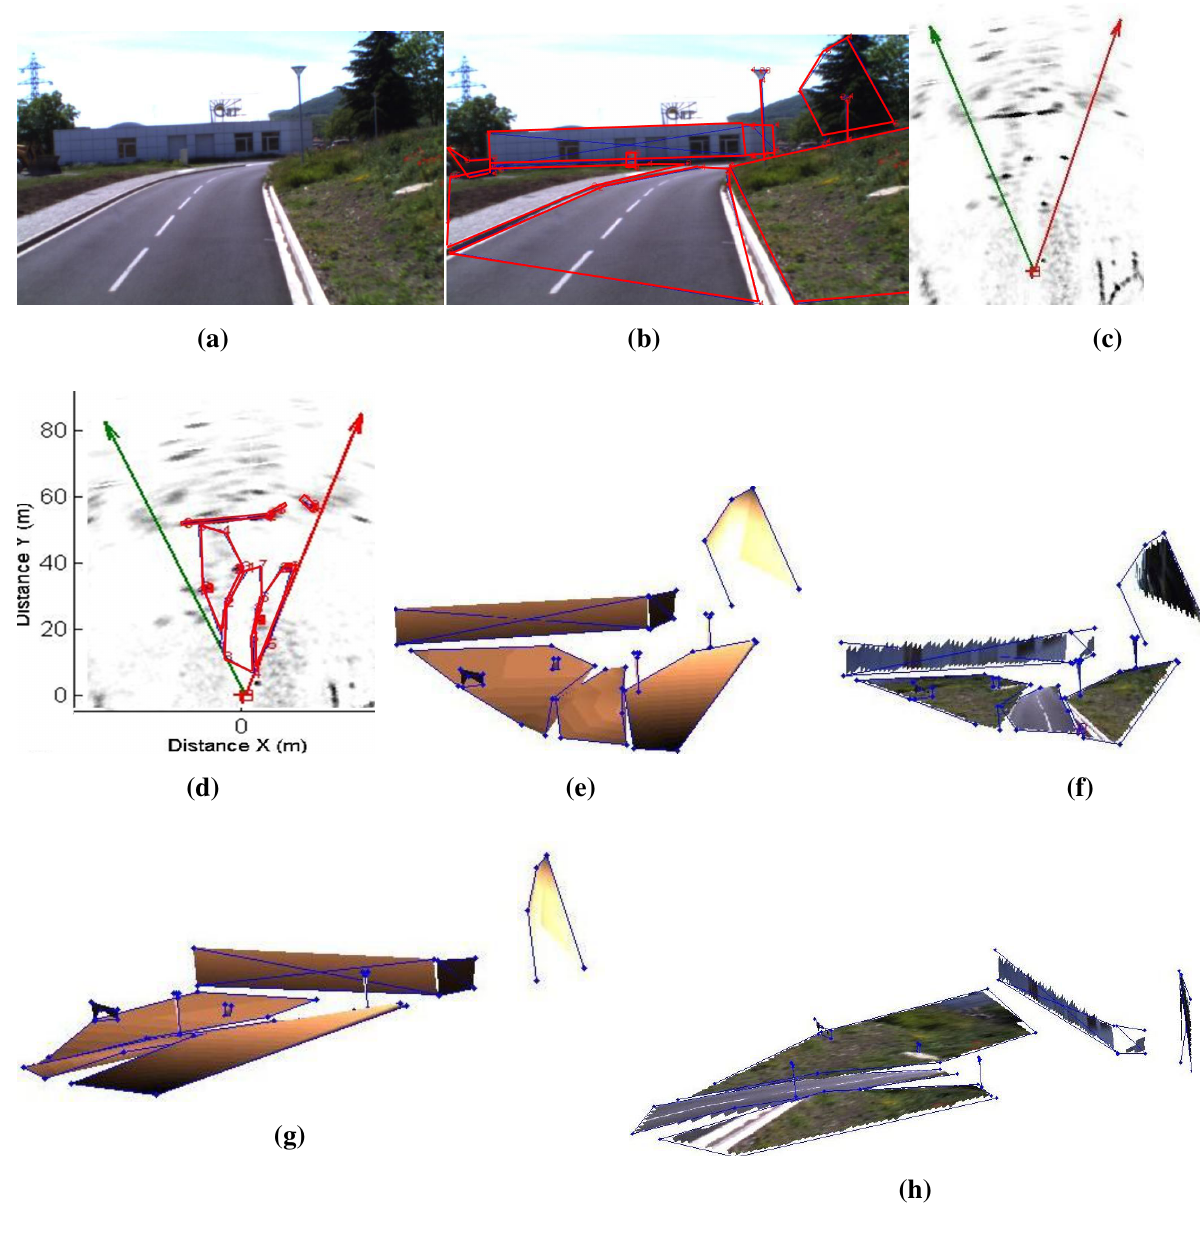
Figure 23. Results of a reconstructed urban scene using the camera/radar system, and the second calibration method. The results are enhanced with texture mapping (this figure is clearer in color). ( a ) Camera image of the an urban scene; ( b ) Segmented camera image; ( c ) Part of the radar image of the same scene; ( d ) Segmented radar image; ( e ) Results of the reconstruction using Delaunay triangulation; ( f ) Enhanced results with texture; ( g ) Another view of the 3D results; ( h ) Another view of the 3D